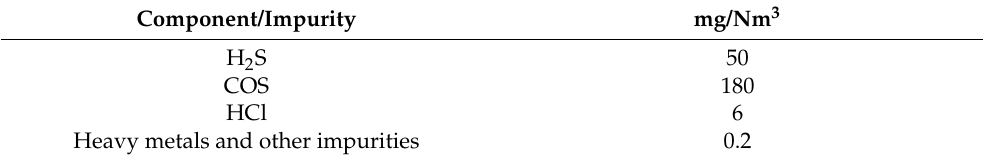
Table 3. Assumed impurities in the steelworks off-gases for the cost estimation.